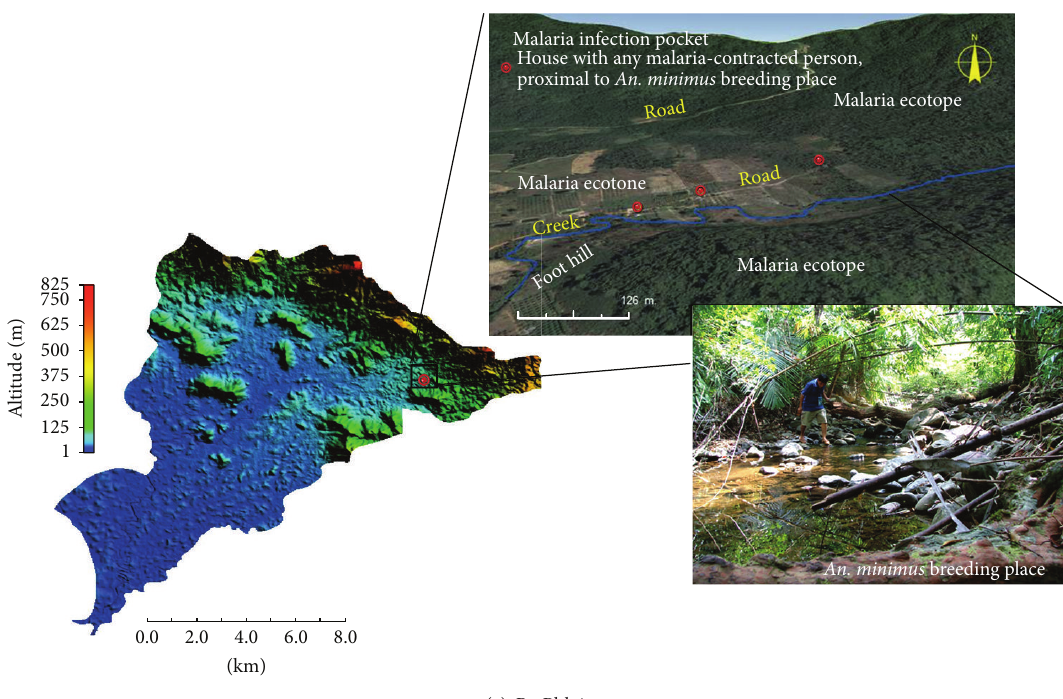
Figure 1: Maps of forest and forest fringe ecotopes of malaria endemic provinces of Thailand. ((a1)-(a2)) Forest and forest fringe ecotopes of malaria endemic provinces, Kanchanaburi and Trat, accommodate the assemblage of main Anopheles vectors. Mapping-based areas (km 2 ) of forests and forest fringes and water bodies are 7,247.97 and 622.87 for Kanchanaburi and 943.63 and 6.61 for Trat. Some subdistrict- level administrative areas of the provinces are shown for malaria transmission control; all of which establish diverse malaria ecotopes and ecotones through changes of land use and land cover patterns pertaining to human activities. Only the subdistrict used in the EES and for establishment of the malaria infection pocket is representative of each province. ((b)-(c)) In Huai Kayeng and Bo Phloi subdistricts, two different malaria infection pockets confined to the TCAs are established for the EES. During September-October 2011, the susceptible persons who developed indigenous malaria were all thought to acquire naturally the infection through bite(s) of potent Anopheles vectors that breed and/or forage close to the patients’ houses. Main drivers are human settlements and activities pertaining to agricultural intensification of the rubber plantations. Among the responsible anophelines, An. aconitus and An. dirus were found to carry MDR vivax malaria parasites during which a course of follow-up treatment of the notified P. vivax patients who received the first-line treatment was done. All topographic maps were performed using the ArcGis ver. 10.0 for the landscape layers of data sources (forest patches, water bodies, Anopheles vector assemblages, and administrative divisions), Global mapper ver. 11.0 for the elevation data, and the Google Earth for the